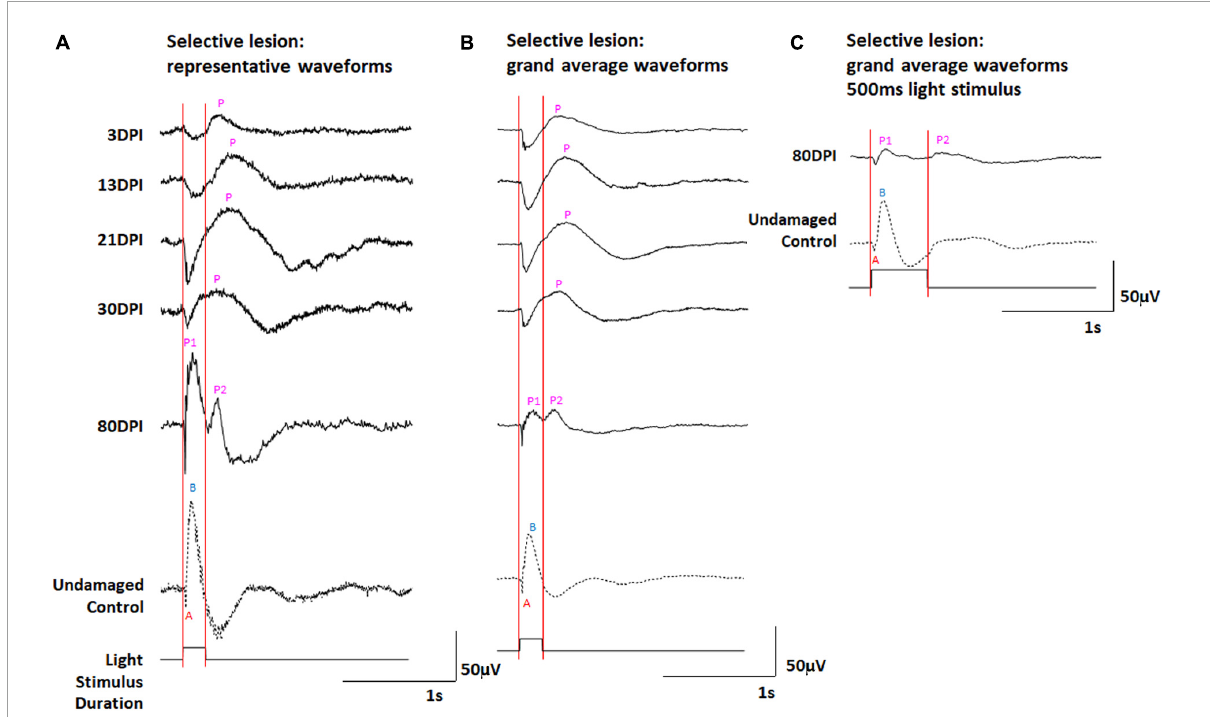
FIGURE4 (A,B) ERG waveforms in response to a 200 ms light flash, over a time-course of retinal regeneration following a selective lesion. (A) Representative waveforms. (B) Grand average waveforms. (C) Grand average ERG waveforms in response to a 500 ms light flash, in undamaged controls and at 80 days post-injury (DPI), modified from (McGinn et al., 2018). A, a-wave; B, b-wave; P, post-photoreceptor response (PPR); P1 and P2, first and second PPRs. Red vertical lines were added to this figure to facilitate comparison of traces in the context of light onset and